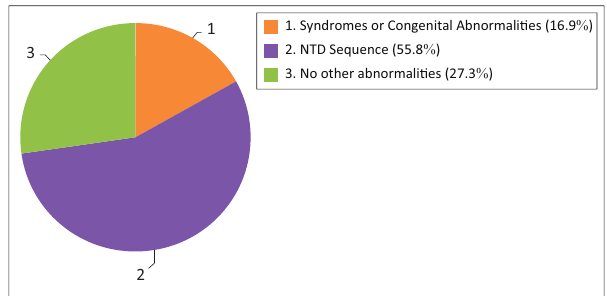
FIGURE 4: Associated congenital abnormalities.